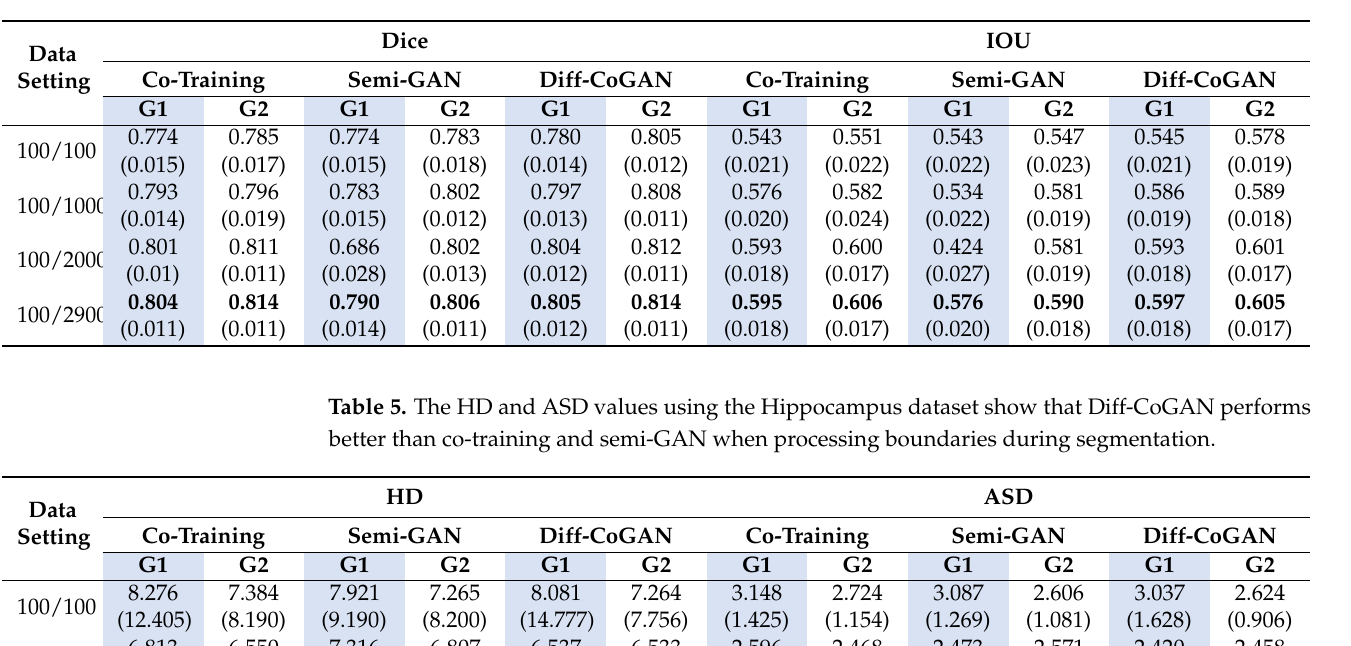
Table 4. The Dice and IoU values of co-training, semi-GAN, and Diff-CoGAN using the Hippocampus dataset. Unlike semi-GAN, co-training and Diff-CoGAN show an improvement in segmentation as more unlabeled data are added to the training.